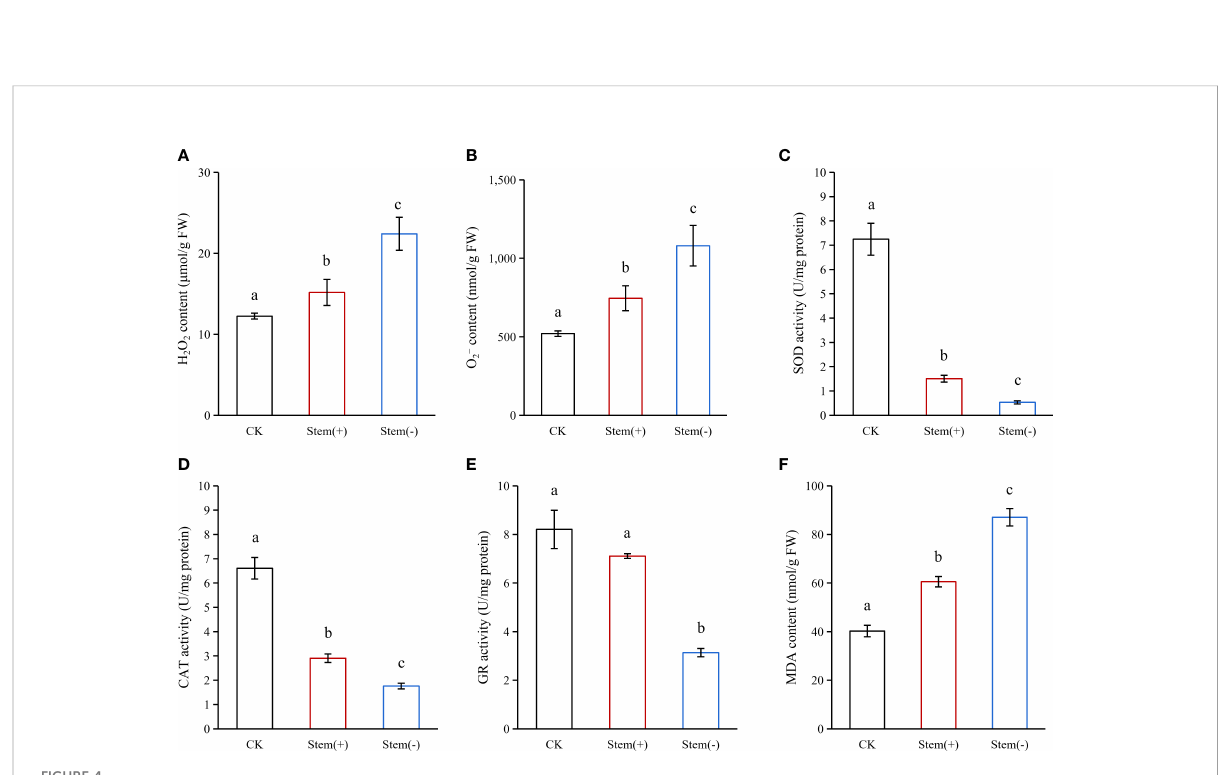
FIGURE 4 Effect of stem on ROS, antioxidant enzymes and cell integrity in fl ue-cured tobacco leaves. FW, fresh weight. Different letters indicate statistically signi fi cant difference at p < 0.05, as determined by t-test.